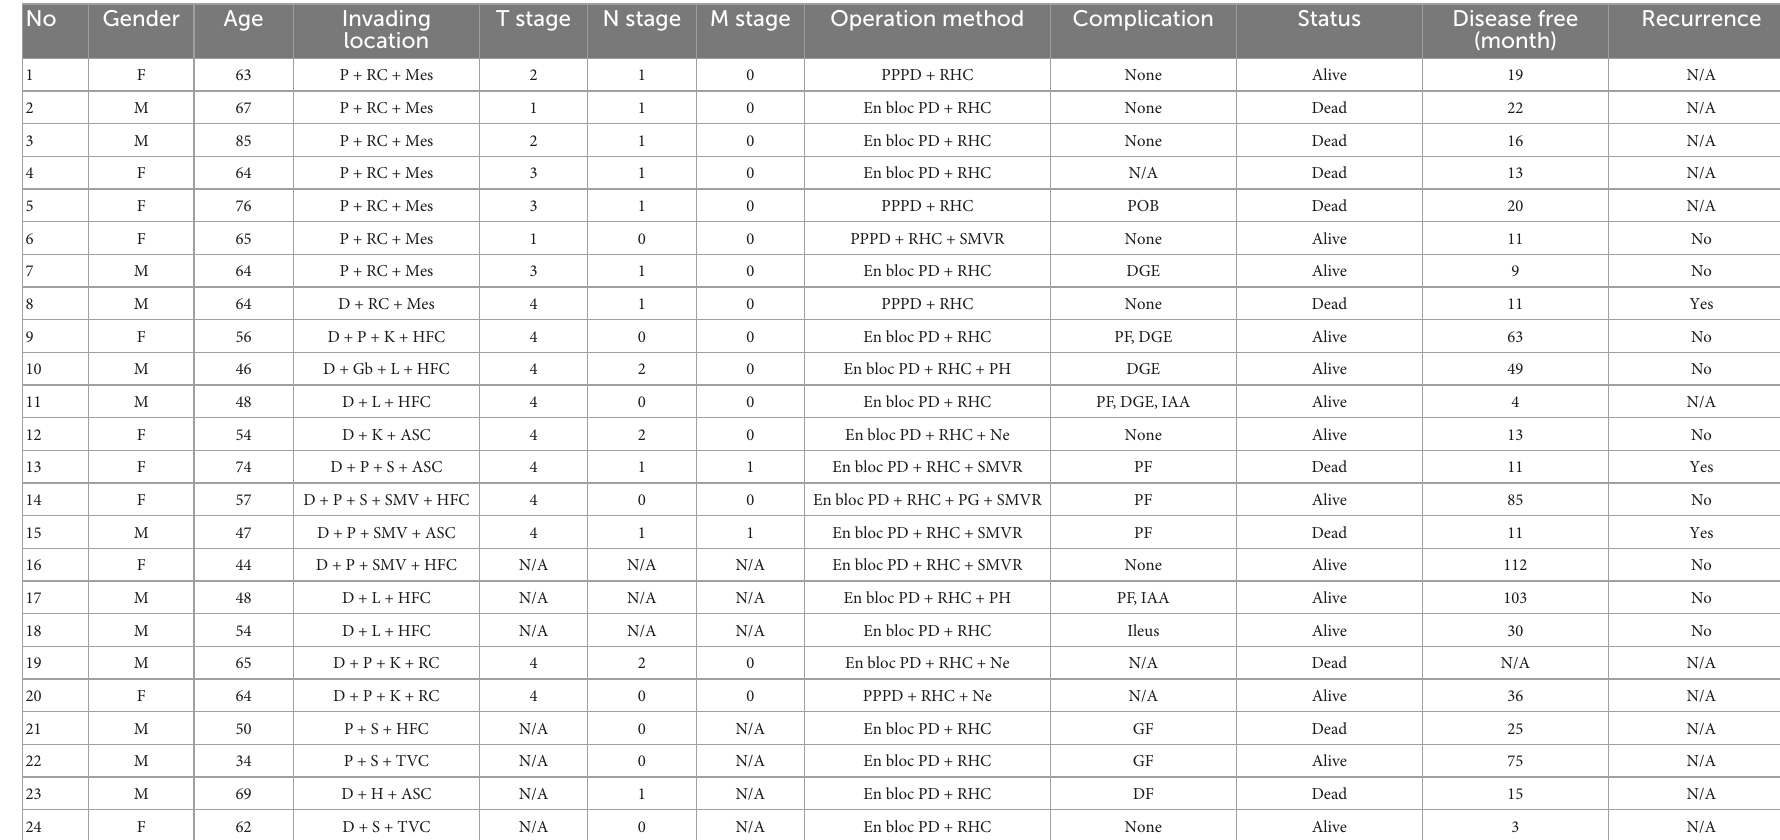
TABLE 5 En bloc PD with RHC when right colon cancer (RCC) invaded pancreas and/or duodenum with other neighboring organs.